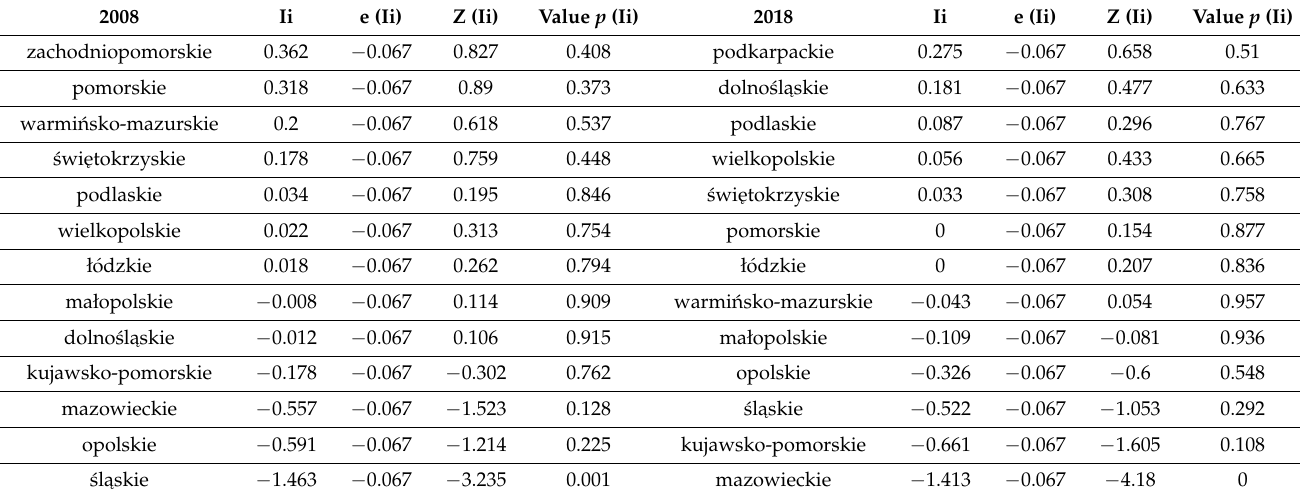
Spatial interactions between the development potential and the division of voivode- ships in Poland are shown in Figure 3. The local statistics of I Moran were determined for each trait. The manner of spatial connections between communes was determined using the neighborhood matrix.